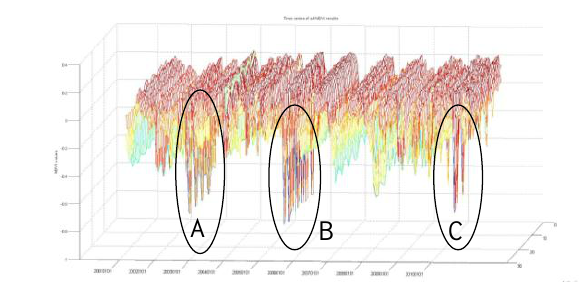
Figure 7-B. Seasonal variations removed 3D NDVI time series.